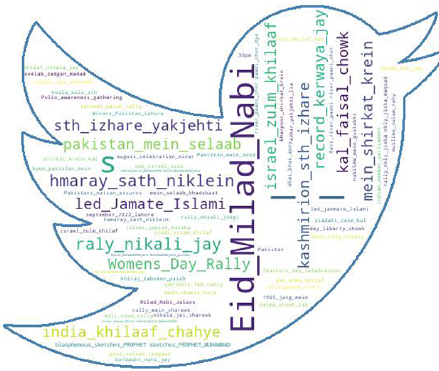
Figure 3. Bigram with positive words.